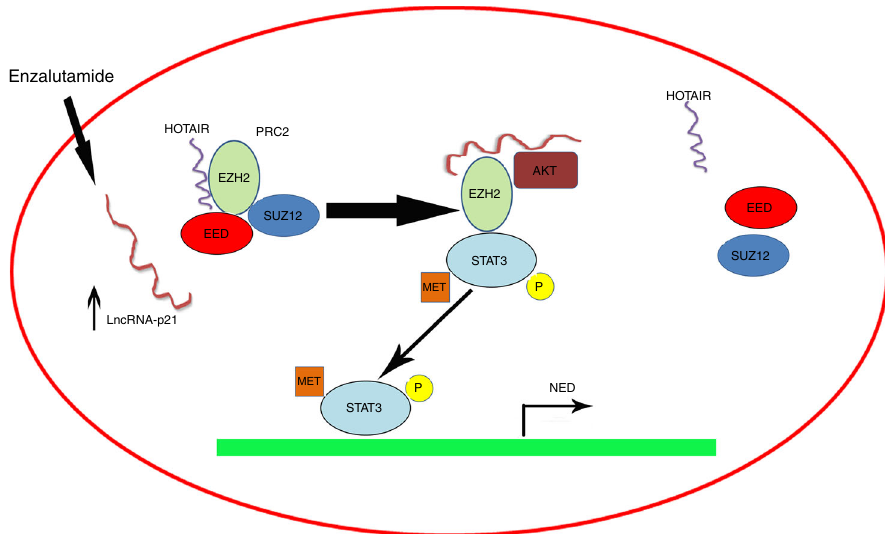
Fig. 9 Schematic depiction of lncRNA-p21/EZH2/STAT3 pathway. Enz treatment induces lncRNA-p21 expression via regulating the AR binding to the lncRNA-p21 promoter in PCa cells. Highly expressed lncRNA-p21 competes with Hotair to interact with EZH2 and disrupt PRC2 complex (SUZ12 and EED). At the same time, lncRNA-p21 promotes AKT phosphorylated EZH2 on Serine 21 and enhances the STAT3 methylation by EZH2. The methylated STAT3 was activated and promotes the